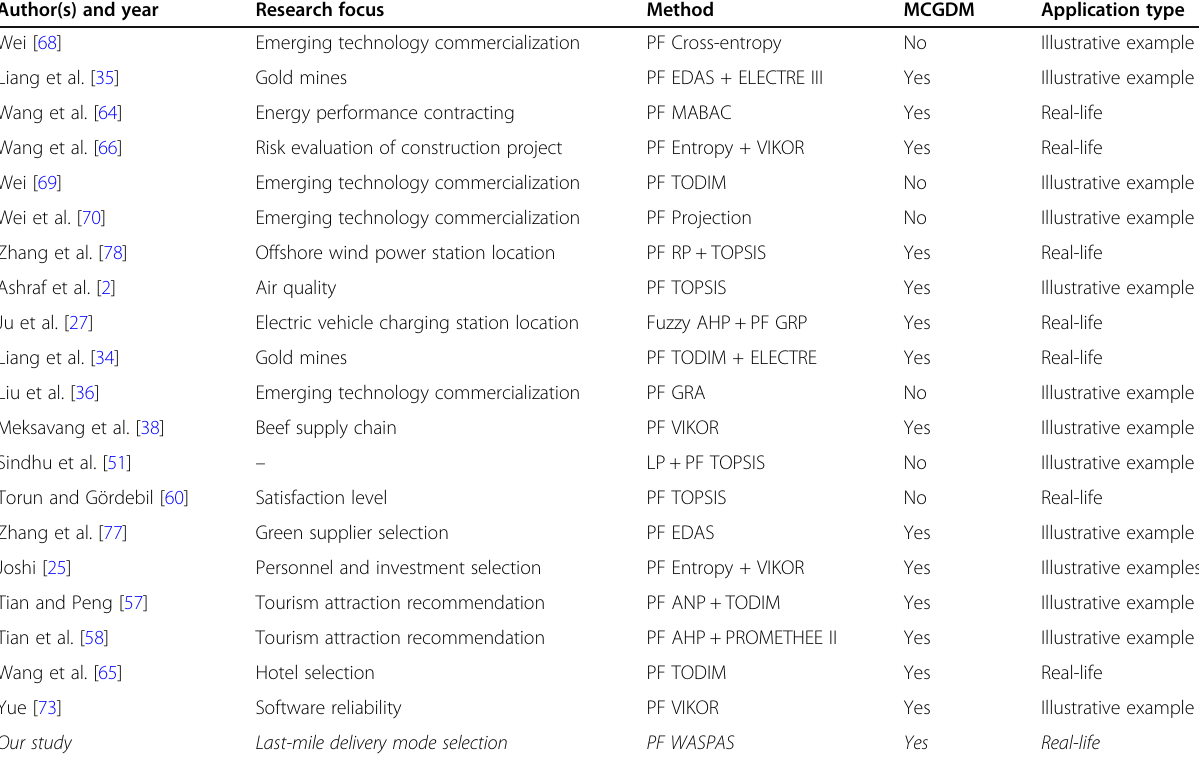
Table 1 Summary of the available picture fuzzy set-based MCDM approaches Author(s) and